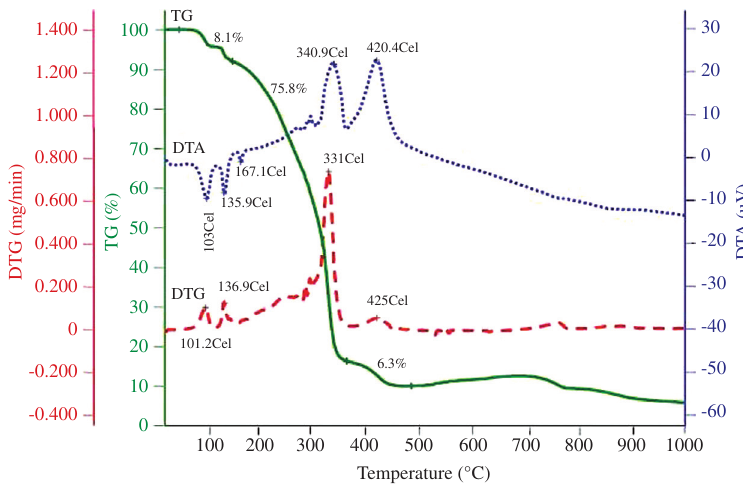
Figure 5 Thermal analyses curves of the Mn complex.